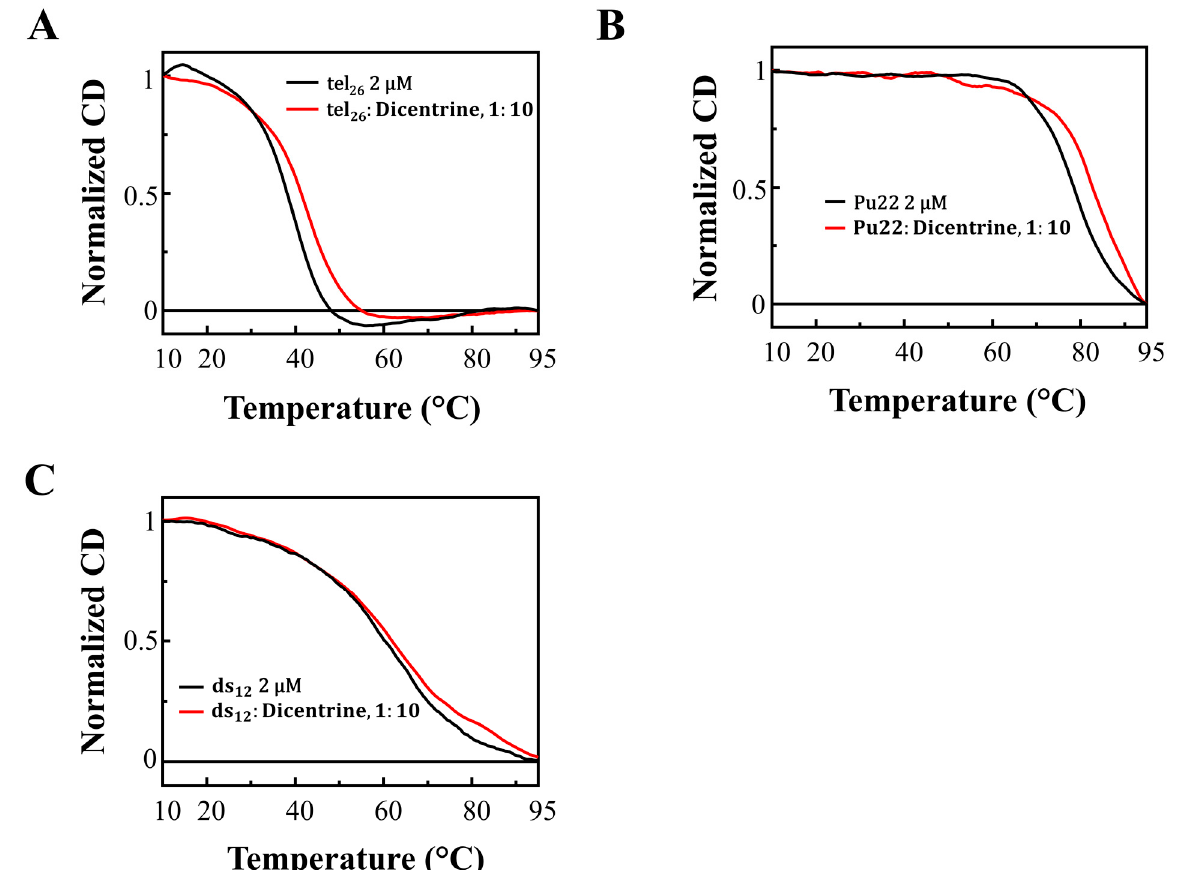
Figure 2. CD melting curves for ( A ) tel 26 G-quadruplex, ( B ) Pu22 G-quadruplex and ( C ) ds 12 duplex in the absence and presence of 10 molar equivalents of Dicentrine in 5 mM KCl, 5 mM KH 2 PO 4 , 5% DMSO buffer (pH 7), recorded at 290, 265 and 253 nm, respectively. Table 3. Melting temperature (T m ) values of tel 26 G-quadruplex, Pu22 G-quadruplex and ds 12 duplex in the absence or presence of Dicentrine (10 molar equivalents) as measured by CD melting